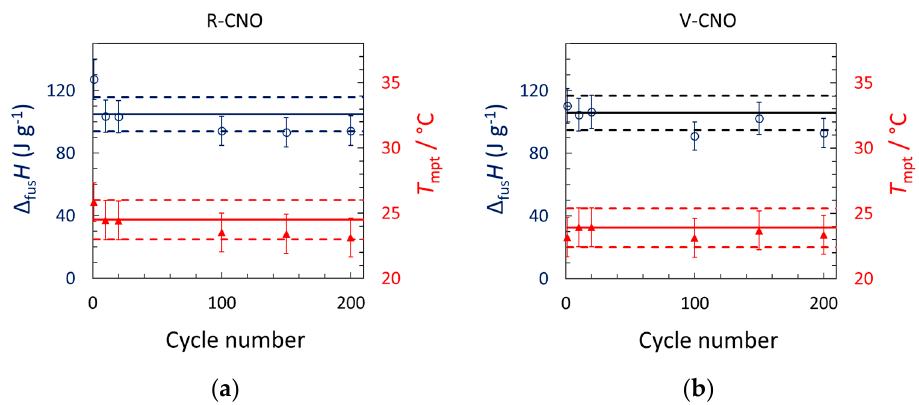
Figure 4. Latent heats of fusion, Δ fus H , (in blue) and melting temperatures, T mpt , (in red) of ( a ) refined coconut oil (R-CNO) and ( b ) virgin coconut oil (V-CNO) as functions of thermal cycle. Although a small change was observed after the first cycle, all values were within the uncertainties of the measurements over the 200 melt-freeze cycles. The solid lines correspond to the average values of Δ fus H and T mpt (calculated from the first 20 heating curves of a fresh sample) and the dashed lines show the range of their uncertainties: ± 10% for Δ fus H and ± 1.5 °C for T mpt .